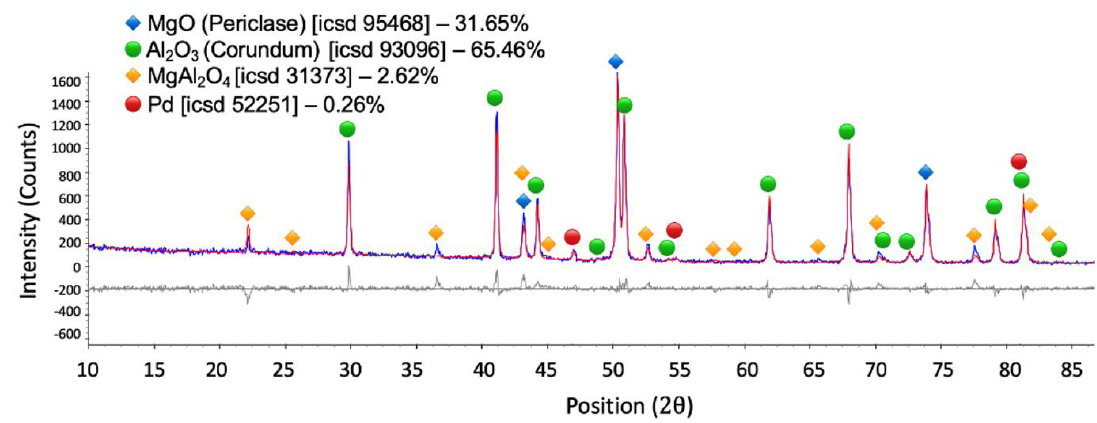
with 20%(wt./wt.) of Pd/Al 4